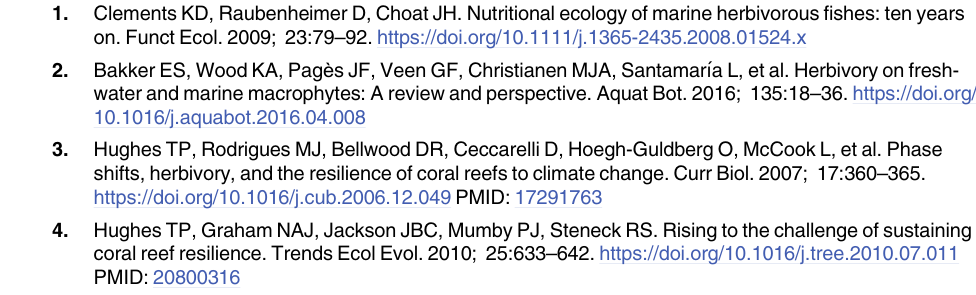
S1 Table. List of herbivorous fish used in this study. S2 Table. Number of 18S rDNA sequences of each taxon taken from NCBI for designing the universal reverse primer and fish (Teleostei) blockers. S3 Table. Number of mismatches between the sequence of each blocker and the 18S rDNA sequence of each taxon in the region of the